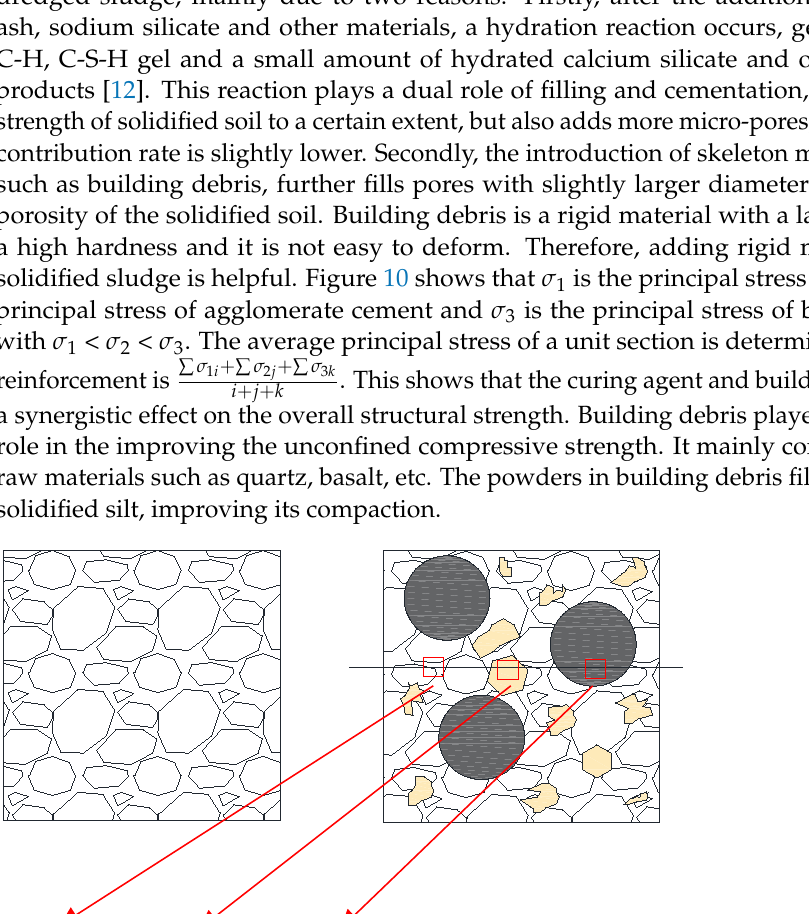
( b ) Figure 9. SEM images of G0 and G8S10. ( a ) G0; ( b ) G8S10 .